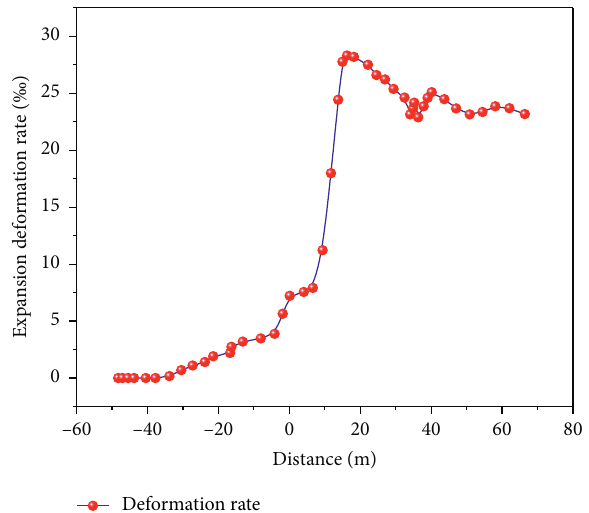
Figure 5: 1672(1) expansion deformation rate of the protected